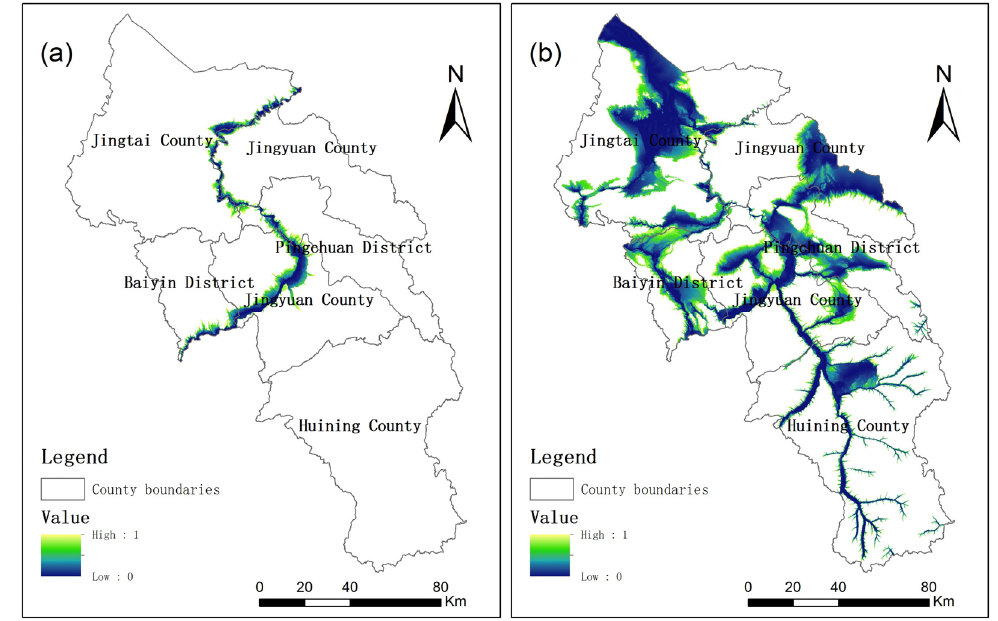
Figure 4. ( a ) CIA of the Yellow River; ( b ) CIA of other agricultural water supply sources.